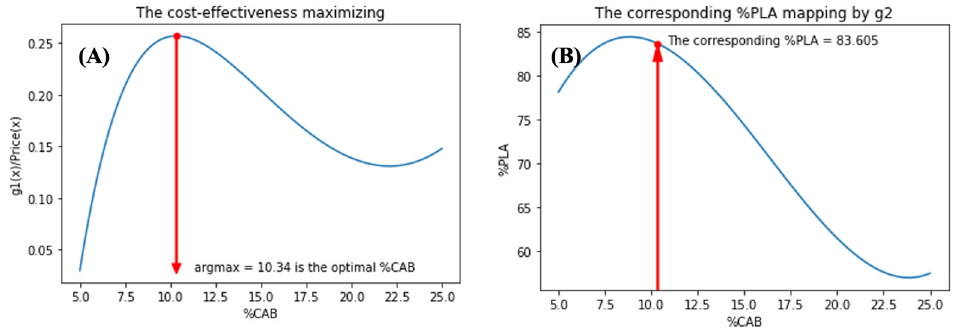
Figure 13. Models showing; the cost-effectiveness maximizing ( A ) and the corresponding %PLA mapping by g 2 ( B ).